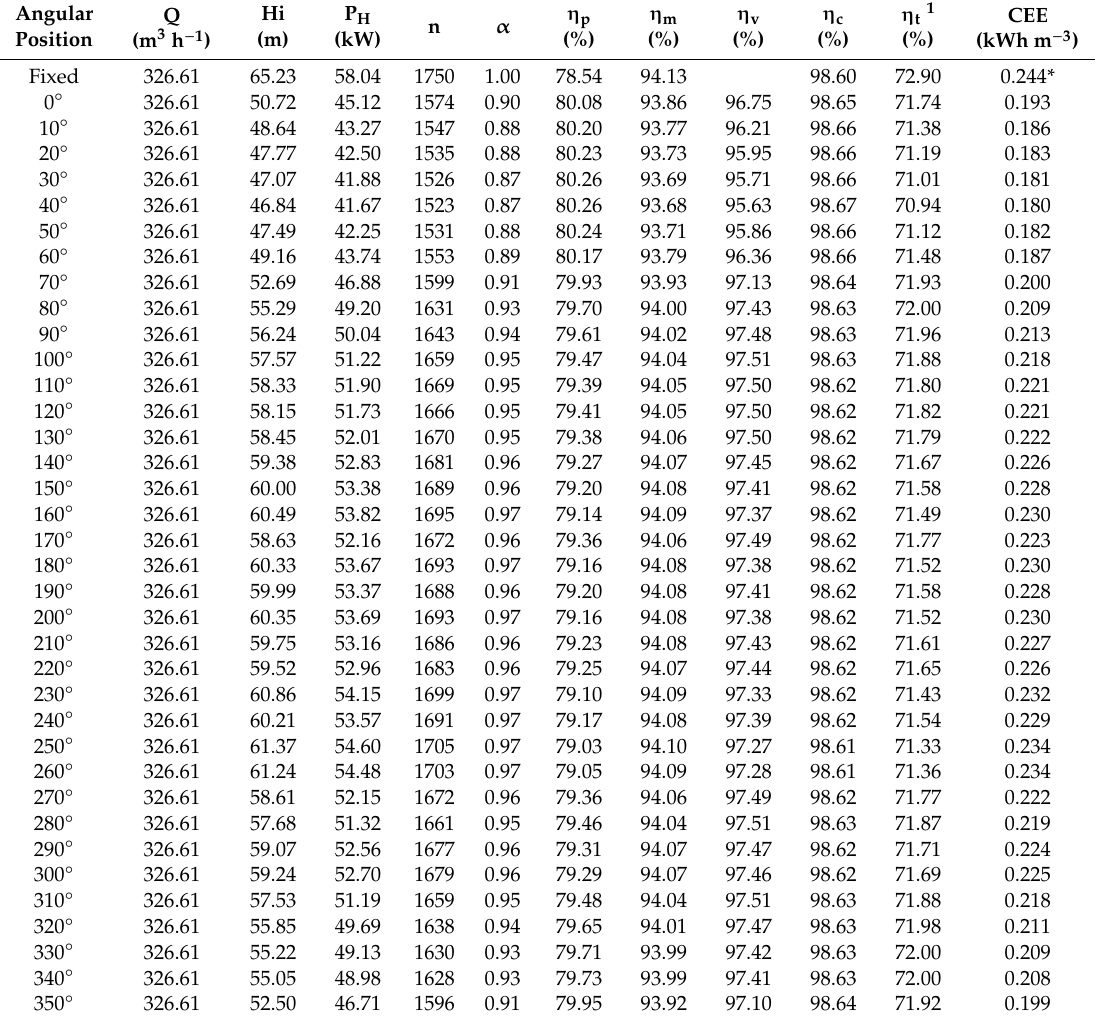
Table 1. Flow rate (Q), pumping pressure head (H i ), hydraulic power (P H ), speed of the pumping station (n), variable speed ratio ( α ), e ffi ciencies ( η ), and specific energy consumption (CEE) in the di ff erent angular positions of the lateral